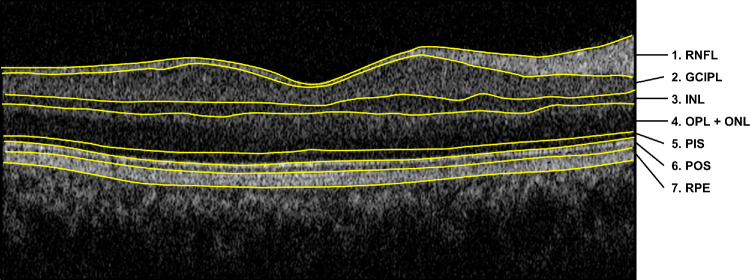
OCT images acquired using Topcon 3D OCT-1000. The seven retinal layers are as follows: (1) RNFL, (2) GCIPL, (3) INL, (4) OPL+ONL, (5) PIS, (6) POS, and (7) RPE.